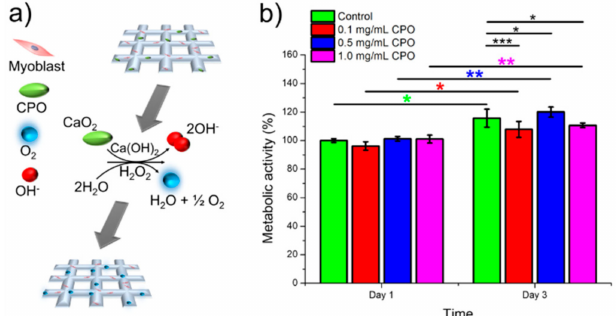
Figure 8. Metabolic activity of C2C12 cells in GelMA bioinks with di ff erent CPO concentrations (0.1, 0.5,